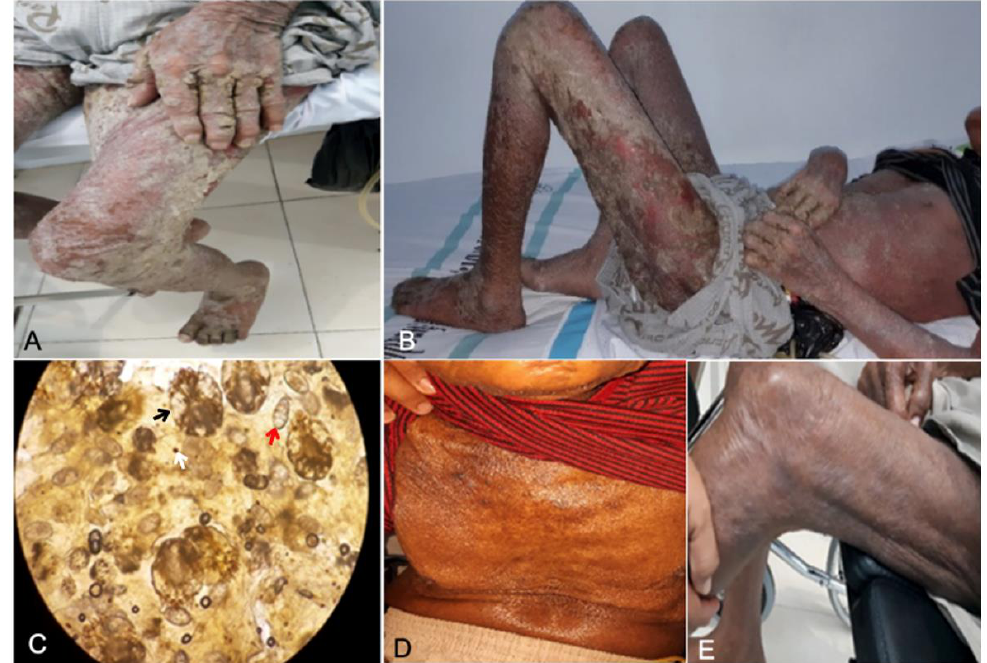
Figure 2. Patient of Case 1 showing diffuse erythematous maculopapular, generalized gray-yellow crusts ( A , B ); mineral oil scraping showing Sarcoptes scabiei mite (black arrow), eggs (red arrow), and feces (white arrow) ( C ); and clinical recovery after four weeks of therapy ( D , E ).